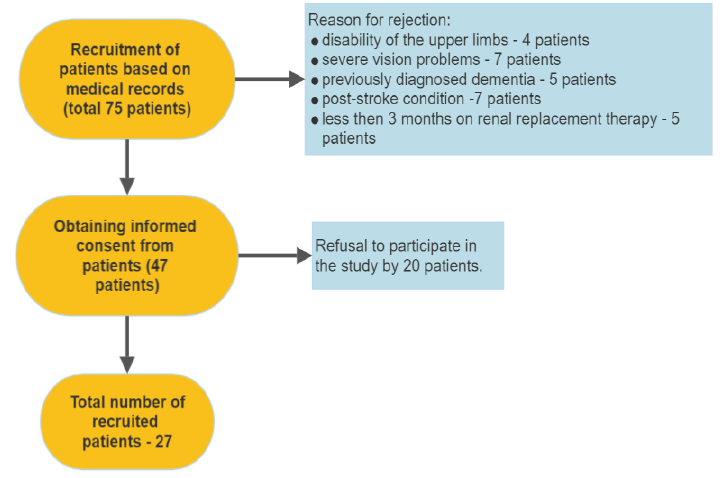
Figure 1. Recruitment process